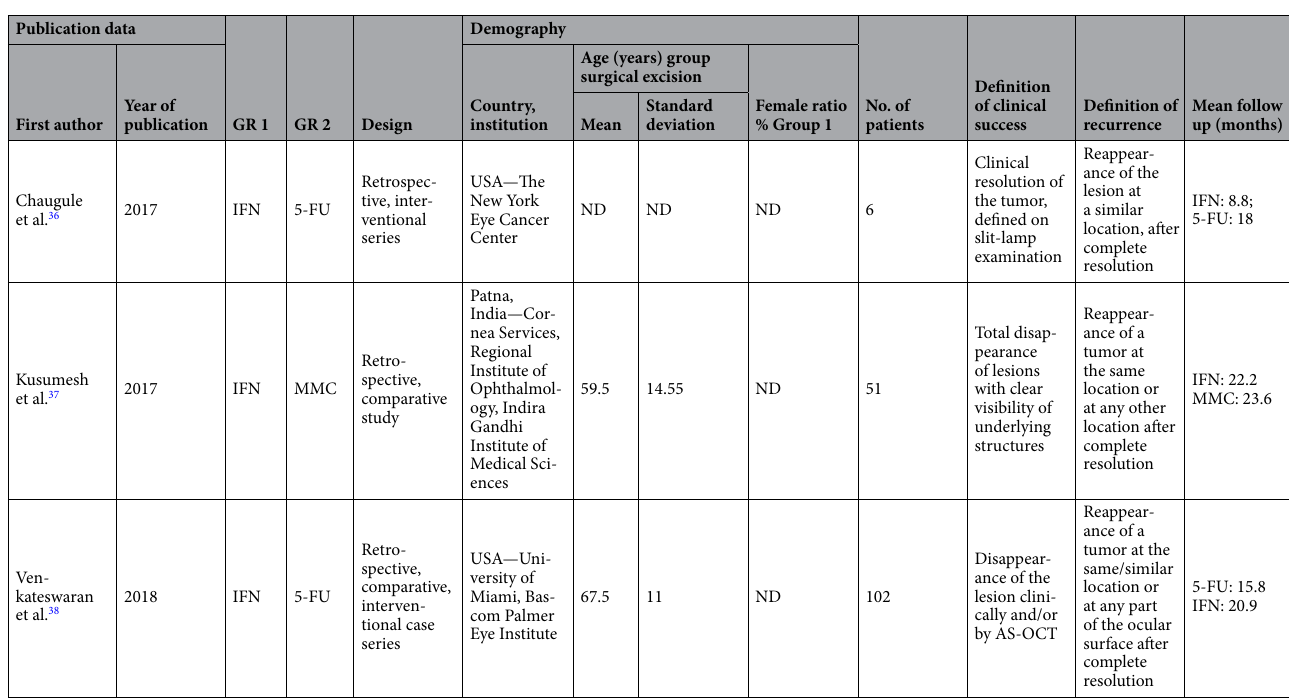
Table 2. Characteristics of studies included only in the qualitative synthesis ND: no